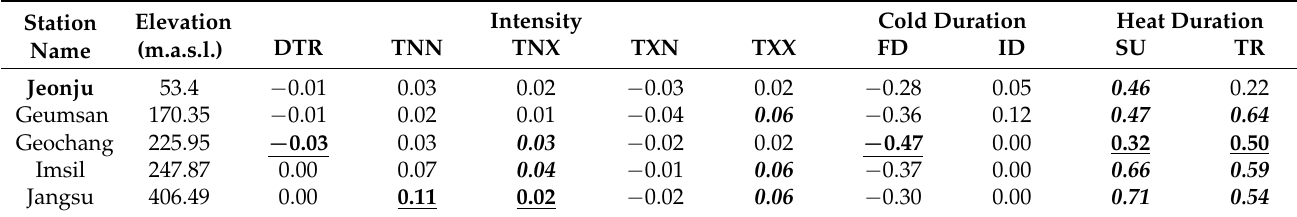
Table A1. Summary of annual trend magnitudes of the temperature indices in the UGRB for 33 years (1998–2020). Station